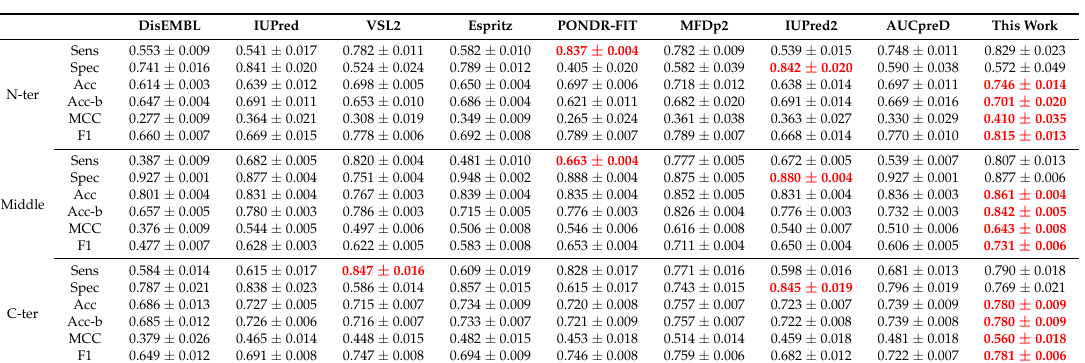
Table 3. Comparison of prediction performance under five-fold cross-validation of eight predictors, as well as the new strategy trained for N-terminal, middle region, and C-terminal residues. The highest value in each of these measures is in bold and highlighted (red).